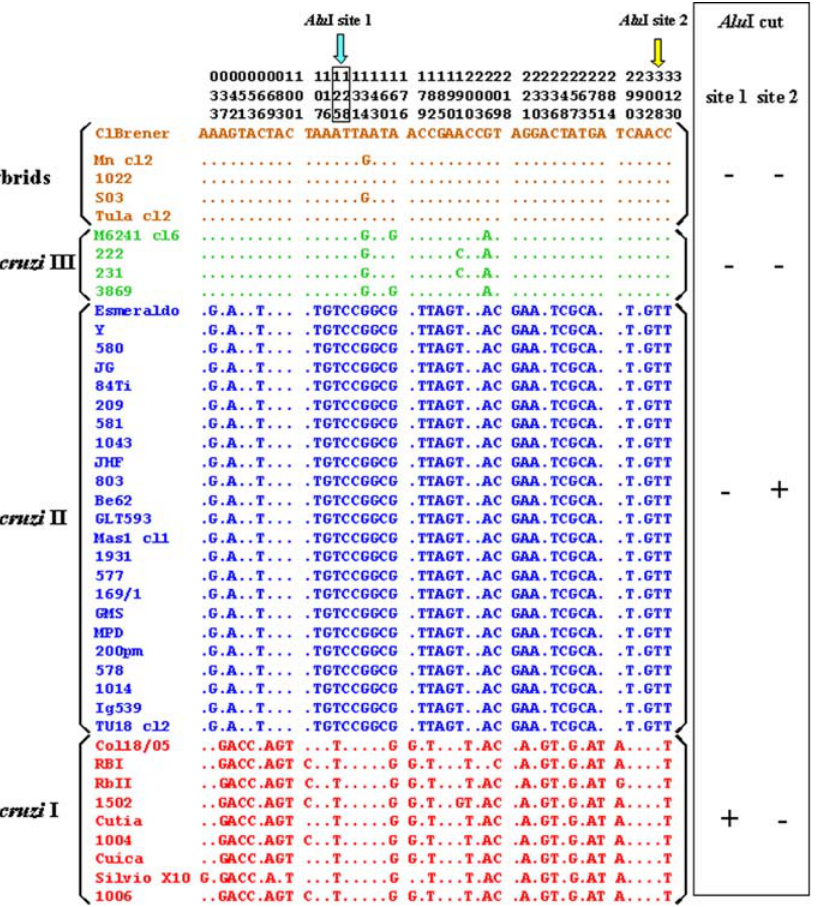
Figure 2. Sequence of a 290–Base Pair Fragment of the Mitochondrial COII Gene of 41 Strains of T. cruzi Only the variable nucleotides are shown. T. cruzi III refers to sublineage IIc, and ‘‘ Hybrids ’’ indicate the strains belonging to sublineages IId and IIe of Brisse et al [26]. Two AluI restriction sites are indicated. RFLP analysis of these two sites allows unambiguous classification of T. cruzi strains to the three mitochondrial clades as shown on the right hand side. DOI: